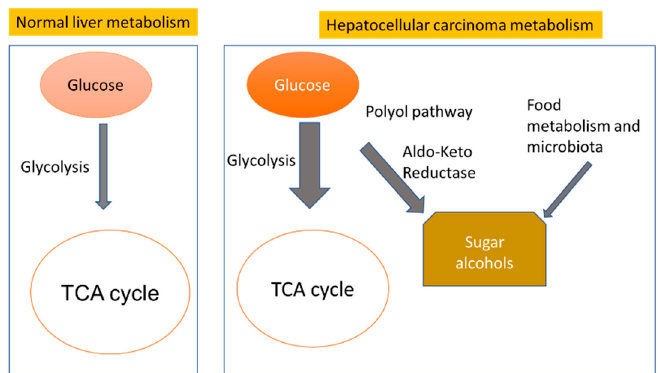
Figure 8. Alternative pathways of carbohydrate metabolism in normal liver metabolism, and dysregulation in hepatocellular carcinomas.